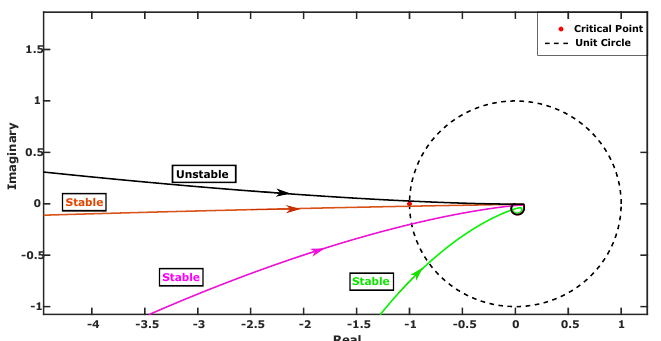
Figure 22. Nyquist Plot (evaluated at point P 1 ) at Low Power Level: Variation of DAB Gains on